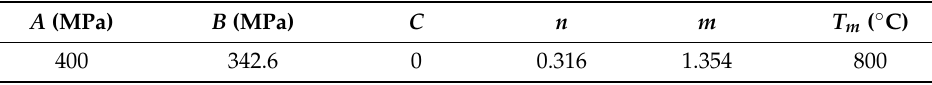
Table 1. Values of J-C equation for these two Aluminum